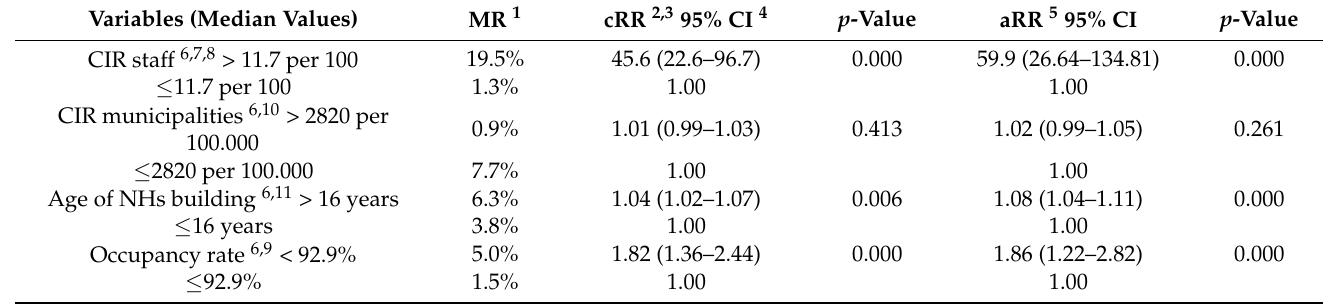
Table 6. Risk factors of the mortality rate (MR) of COVID-19 in residents of nursing homes (II). Health Departments 2 and 3 of Castellon. March 2020–January